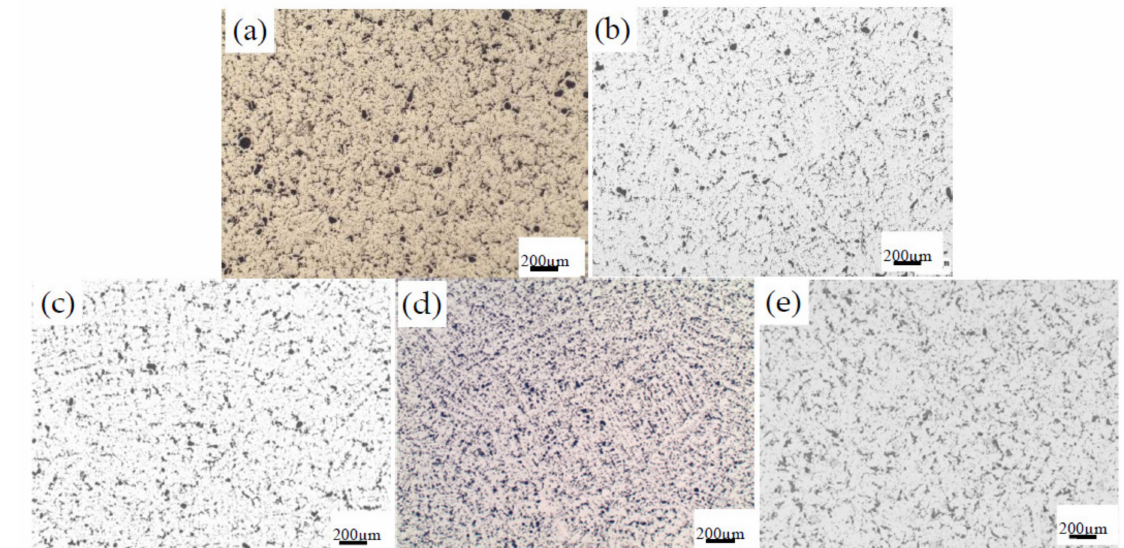
Figure 1. The microstructure of ZCuPb20Sn5-0.1P alloy with different content of B: ( a ) B 0 wt.%, ( b ) B 0.01 wt.%, ( c ) B 0.05 wt.%, ( d ) B 0.1 wt.%, ( e ) B 0.2 wt.%.